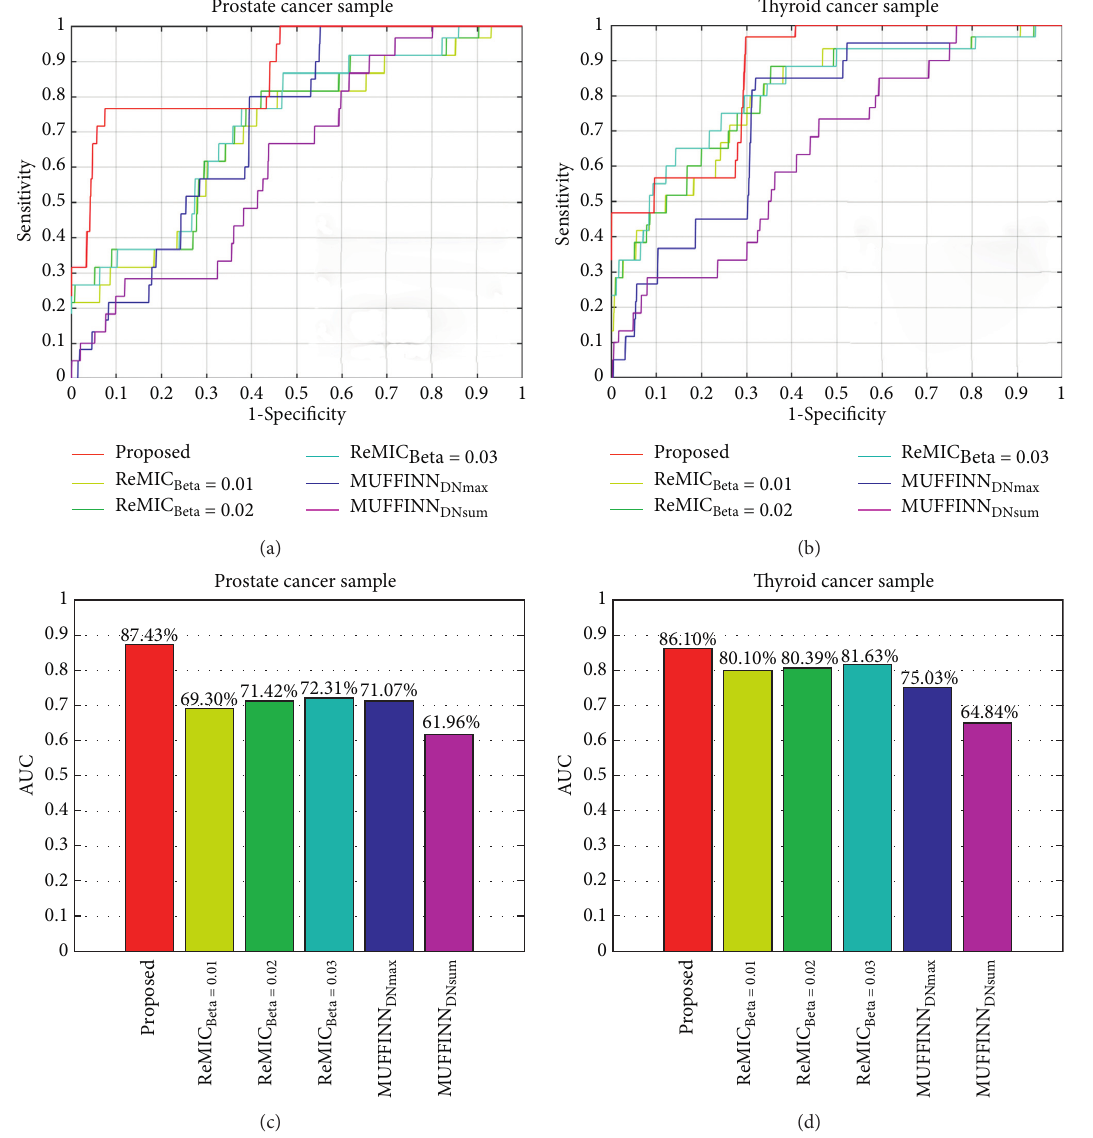
Figure 2: Performance evaluation of the compared methods on STRING network via ROC curves and AUC values. (a) ROC curve for prostate cancer. (b) ROC curve for thyroid cancer. (c) AUC for prostate cancer. (d) AUC values for thyroid